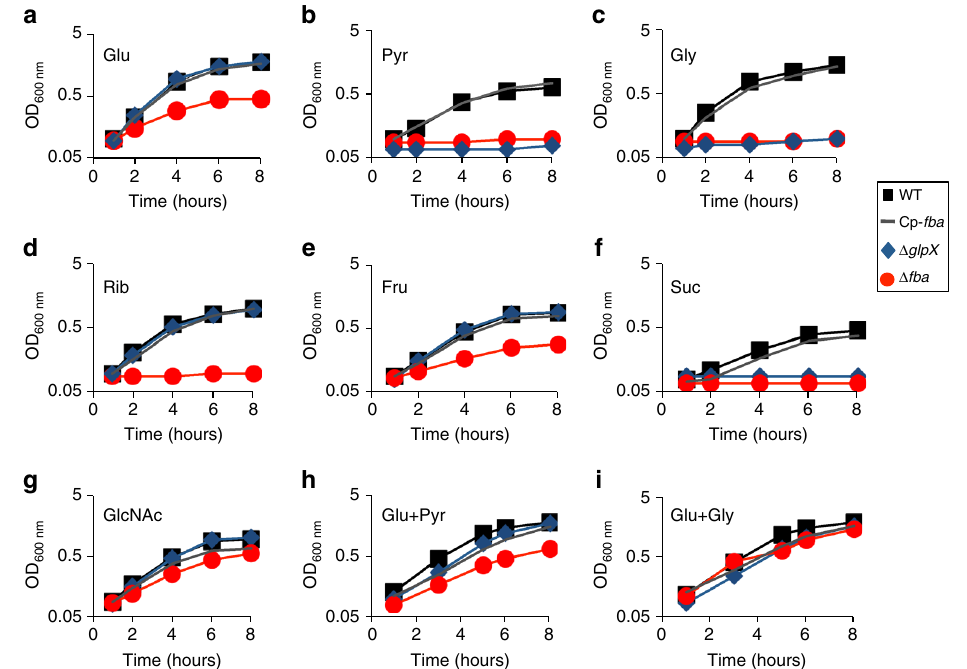
Fig. 2 FBA inactivation inhibits growth of Francisella in the presence of various carbon sources. Wild-type F. novicida (WT, close black squares ), isogenic Δ fba mutant ( Δ fba , red circles ), and complemented fba strain ( Δ fba Cp- fba , gray line ), and isogenic Δ glpX mutant ( Δ glpX , blue diamond) , were grown in chemically de fi ned medium (CDM) lacking glucose and supplemented with different carbon source at a fi nal concentration of 25 mM. a Glucose (Glc); b Pyruvate (Pyr); c Glycerol (Gly); d Ribose (Rib); e Fructose (Fru); f Succinate (Suc); g N-Acetylglucosamine (GlcNAc); h Glucose+ Pyruvate (Glc + Pyr); i Glucose + Glycerol (Glc + K12 (eco: b2925), with 27 and 25.6% amino acid identity, respectively. The FBA protein sequence does not contain any